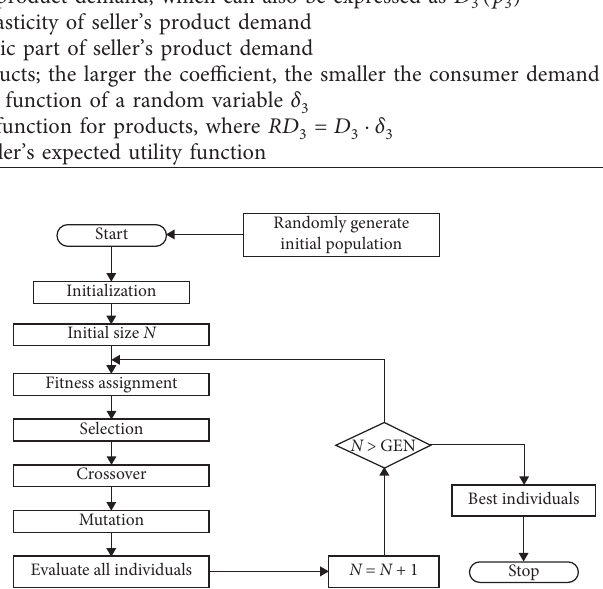
Figure 2: Basic flowchart of